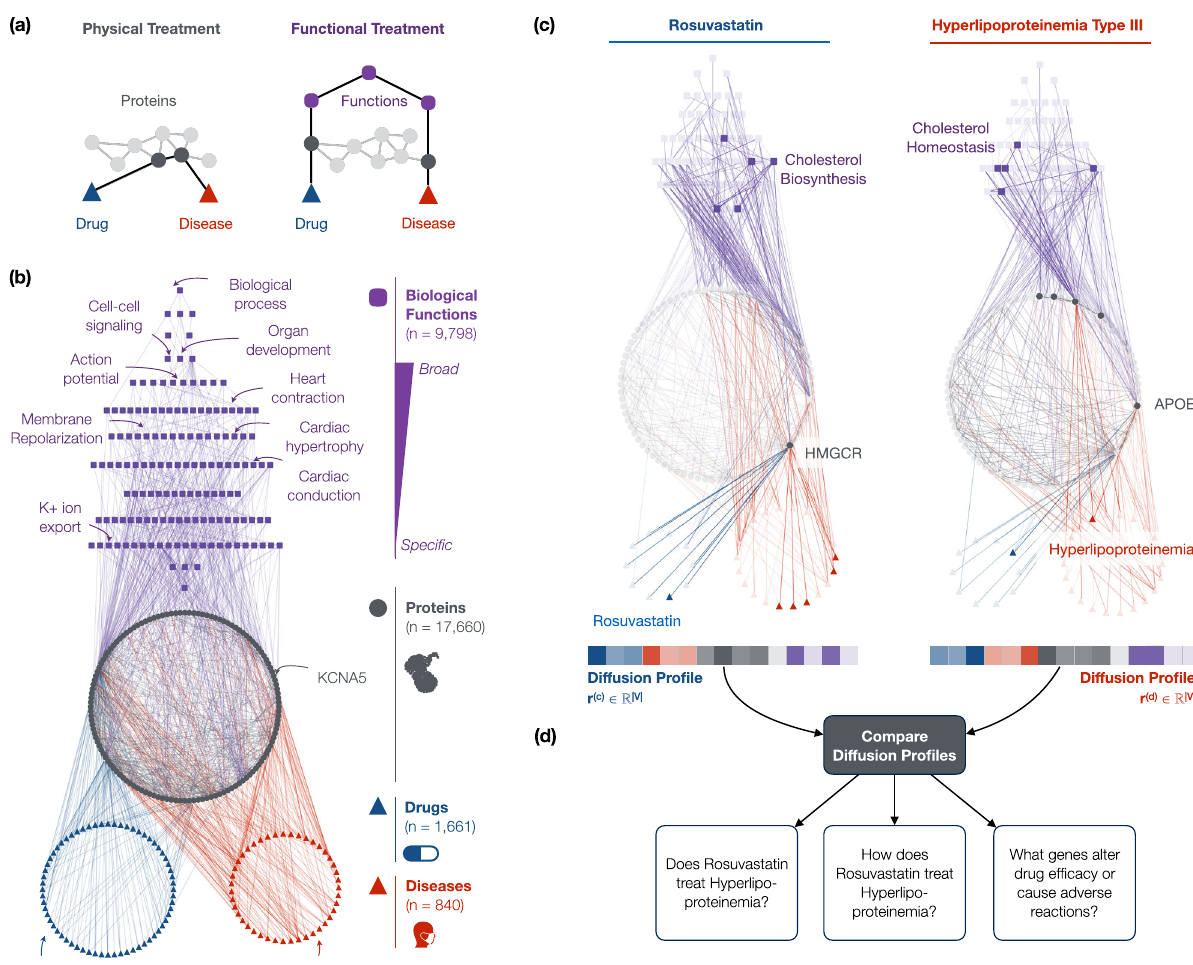
Fig. 1 The multiscale interactome models drug treatment through both proteins and biological functions. a Existing systematic network approaches assume that drugs treat diseases by targeting proteins that are proximal to disease proteins in a network of physical interactions 10 – 14 . However, drugs can also treat diseases by targeting distant proteins that affect the same biological functions (Supplementary Fig. 3) 20 – 25 . b The multiscale interactome models drug-disease treatment by integrating both proteins and a hierarchy of biological functions (Supplementary Fig. 1). c The diffusion pro fi le of a drug or disease captures its effect on every protein and biological function. The diffusion pro fi le propagates the effect of the drug or disease via biased random walks which adaptively explore proteins and biological functions based on optimized edge weights. Ultimately, the visitation frequency of a node corresponds to the drug or disease ’ s propagated effect on that node (see the “ Methods ” section). d By comparing the diffusion pro fi les of a drug and disease, we compare their effects on both proteins and biological functions. Thereby, we predict whether the drug treats the disease (Fig. 2a – c), identify proteins and biological functions related to treatment (Fig. 2d – h), and identify which genes alter drug ef fi cacy or cause dangerous adverse reactions (Fig. 3). For example, Hyperlipoproteinemia Type III ’ s diffusion pro fi le reveals how defects in APOE affect cholesterol homeostasis, a hallmark of the excess blood cholesterol found in patients 50 – 54 . The diffusion pro fi le of Rovustatin, a treatment for Hyperlipoproteinemia Type III, reveals how binding of HMG- CoA reductase (HMGCR) reduces the production of excess cholesterol 55,56 . By comparing these diffusion pro fi les, we thus predict that Rosuvastatin treats Hyperlipoproteinemia Type III, identify the HMGCR and APOE-driven cholesterol metabolic functions relevant to treatment, and predict that mutations in APOE and HMGCR may interfere with treatment and thus alter drug ef fi cacy or cause dangerous adverse